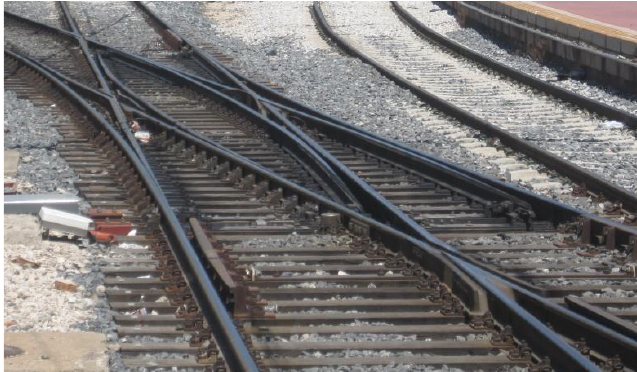
Figure 7. A double-slip turnout.